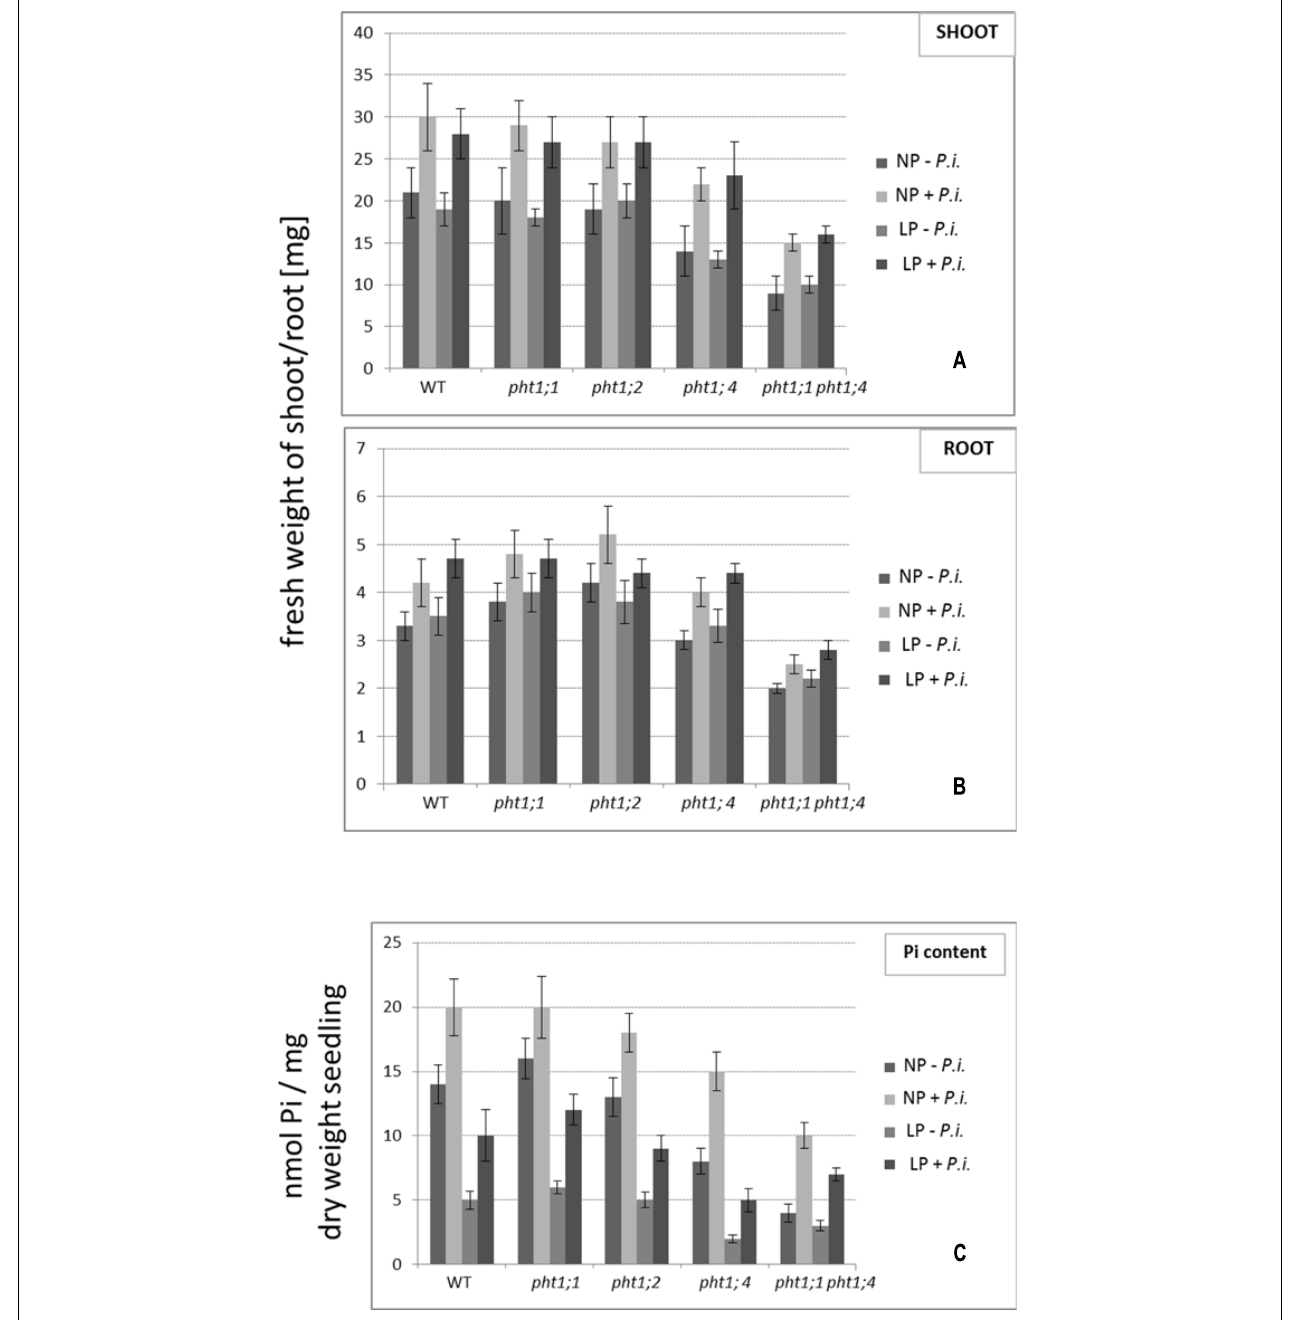
FIGURE 5 | The effect of P. indica on the fresh weights (A,B) and Pi content (C) of WT and pht1 mutant seedlings grown on NP and LP medium. Seedlings were transferred to PNM medium with either NP or LP and with or without P. indica and the shoots and roots were harvested separately after 2 weeks. Based on five independent co-cultivation experiments with 60 seedlings per treatment and genotype. Bars represent